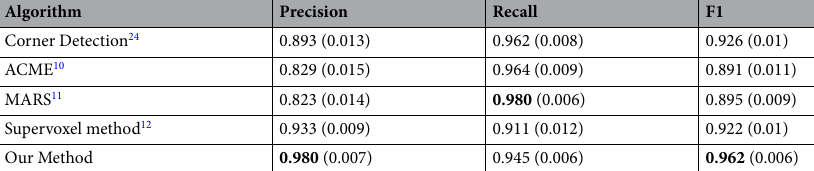
Table 7. Quantitative analysis on error of junctions of three cell walls. The bold values represent the best performing method for each of the metrics. Precision, recall, and F1 score are used to evaluate the detection of those junctions. Number in parenthesis are standard deviation values across all images